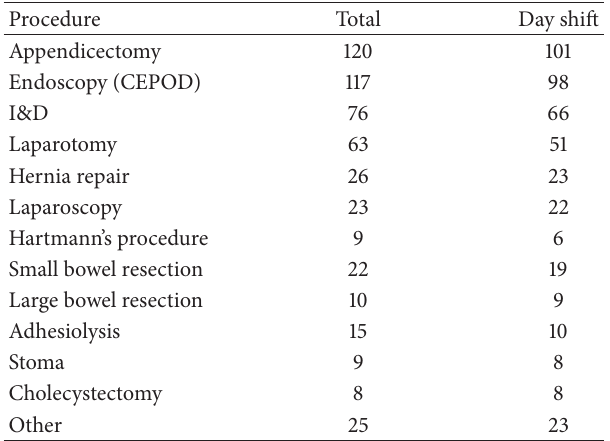
Table 2: Emergency procedures performed overall and during the day